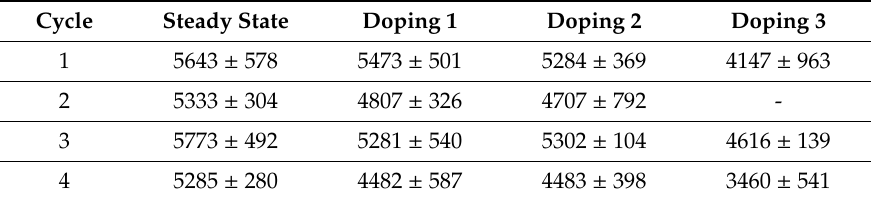
Table 3. Average Mixed liquor suspended solids (MLSS) (mg / L) in steady state and the three dopings for the four cycles